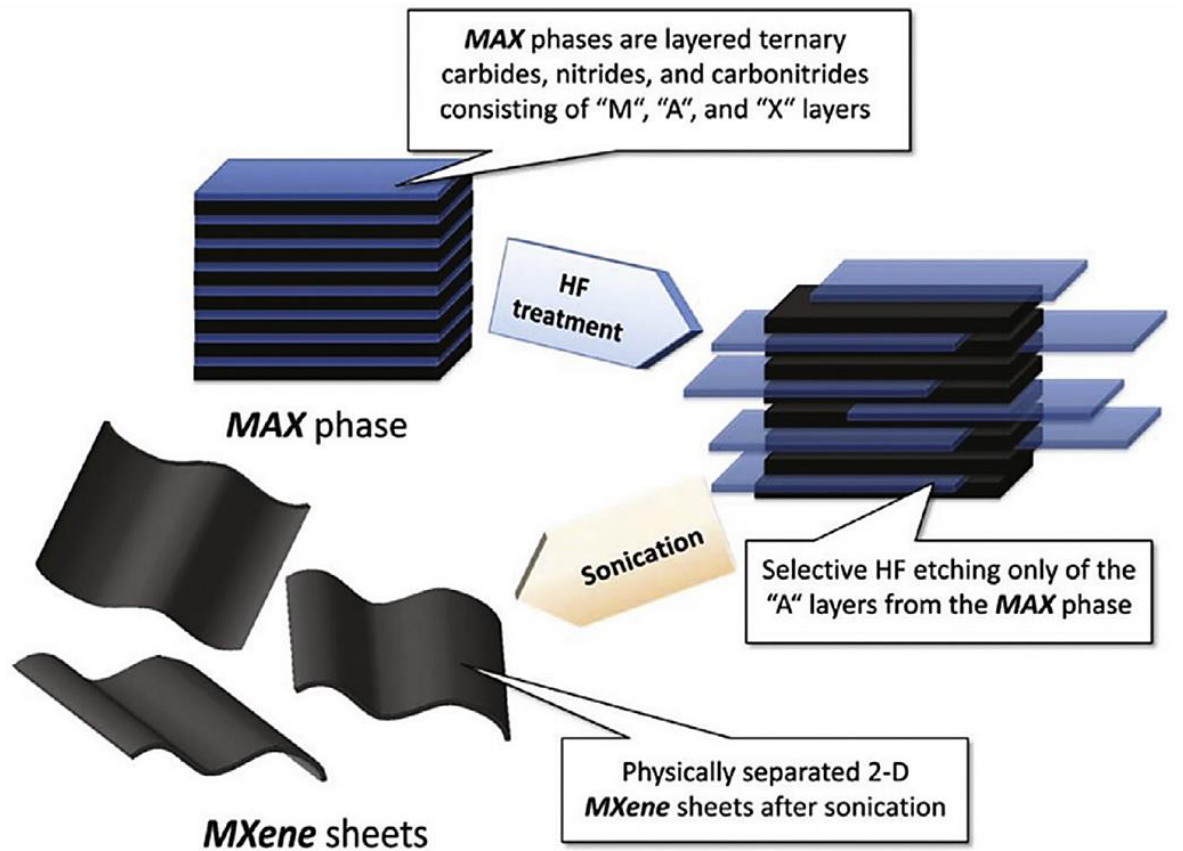
Figure 1. Schematic figure with crystal structure showing the conversion of MAX ( top ) to MXene ( bottom ). Reprinted with permission from Reference [2].